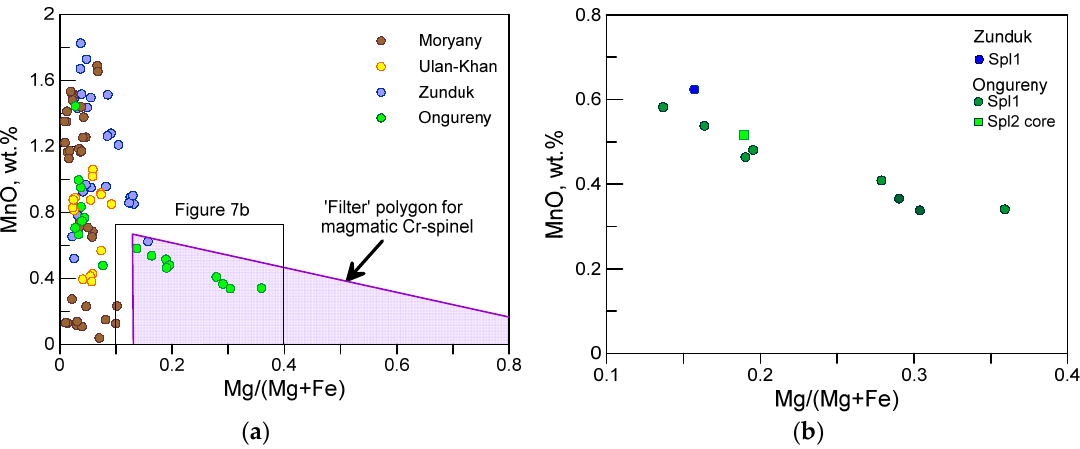
Figure 7. Mg / (Mg + Fe 2 + ) vs. MnO (wt.%) diagram. ( a ) The entire Cr-spinel data set; ( b ) Selected Figure 7. Mg/Mg + Fe 2+ vs. MnO (wt.%) diagram. ( a ) The entire Cr-spinel data set; ( b ) Selected analyses analyses that fall into the ‘Filter’ polygon that fall into the ‘Filter’ polygon [11].